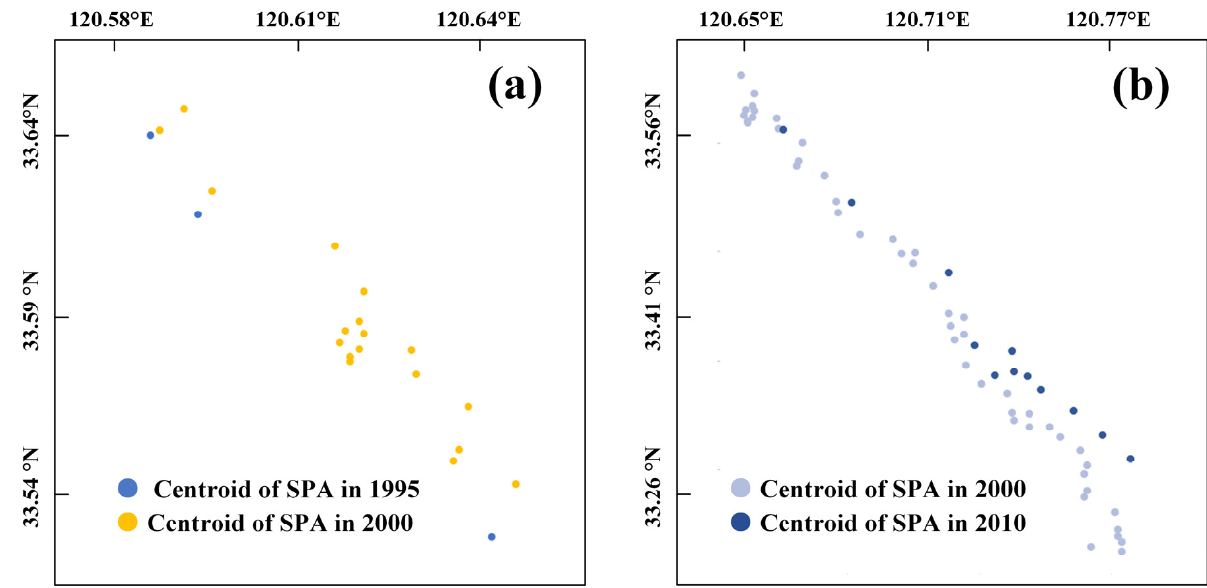
Figure 12. ( a ) Distribution of centroids of S. alterniflora patches (SAP) between Xinyang Port and Doulong Port in 1995 and 2000. ( b ) Distribution of centroids of S. alterniflora patches between Doulong Port and Dafeng Port in 2000 and 2010.